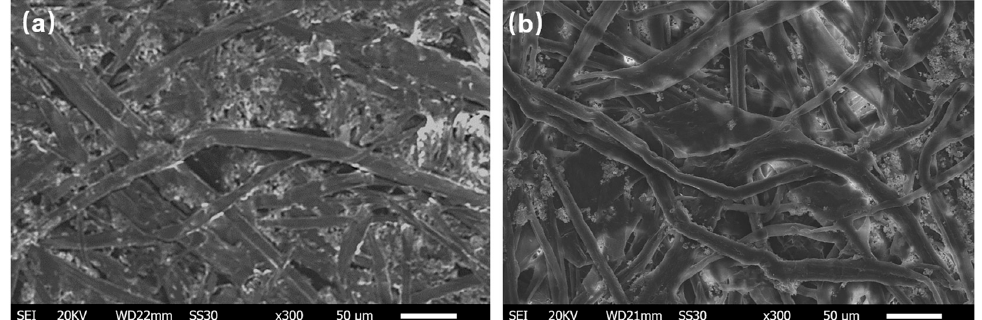
Figure 3. Scanning electron microscope ( SEM) images of the surface of ( a ) the paper coated with graphite (GOP substrate), and ( b ) 8 nm Pd thin film deposited on the GOP substrate.